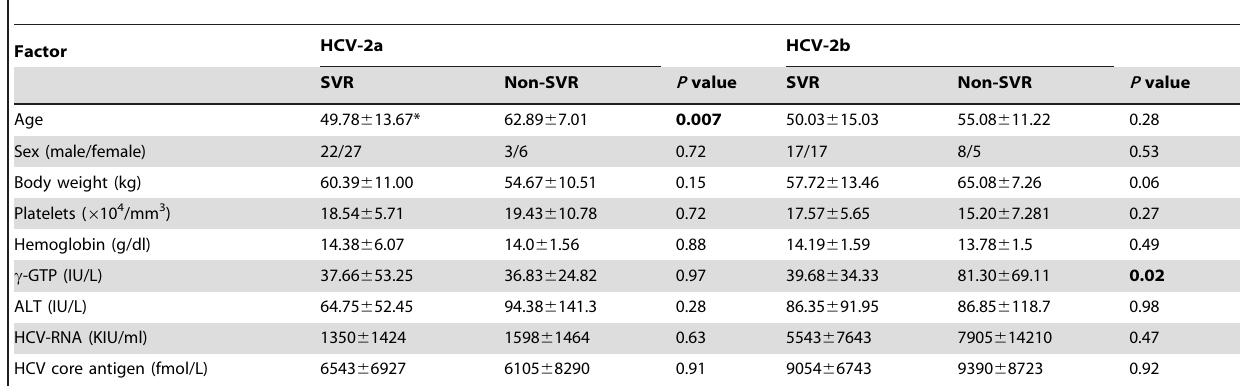
Table 2. Demographic characteristics of HCV-2a- and HCV-2b-infected patients with SVR and non-SVR.